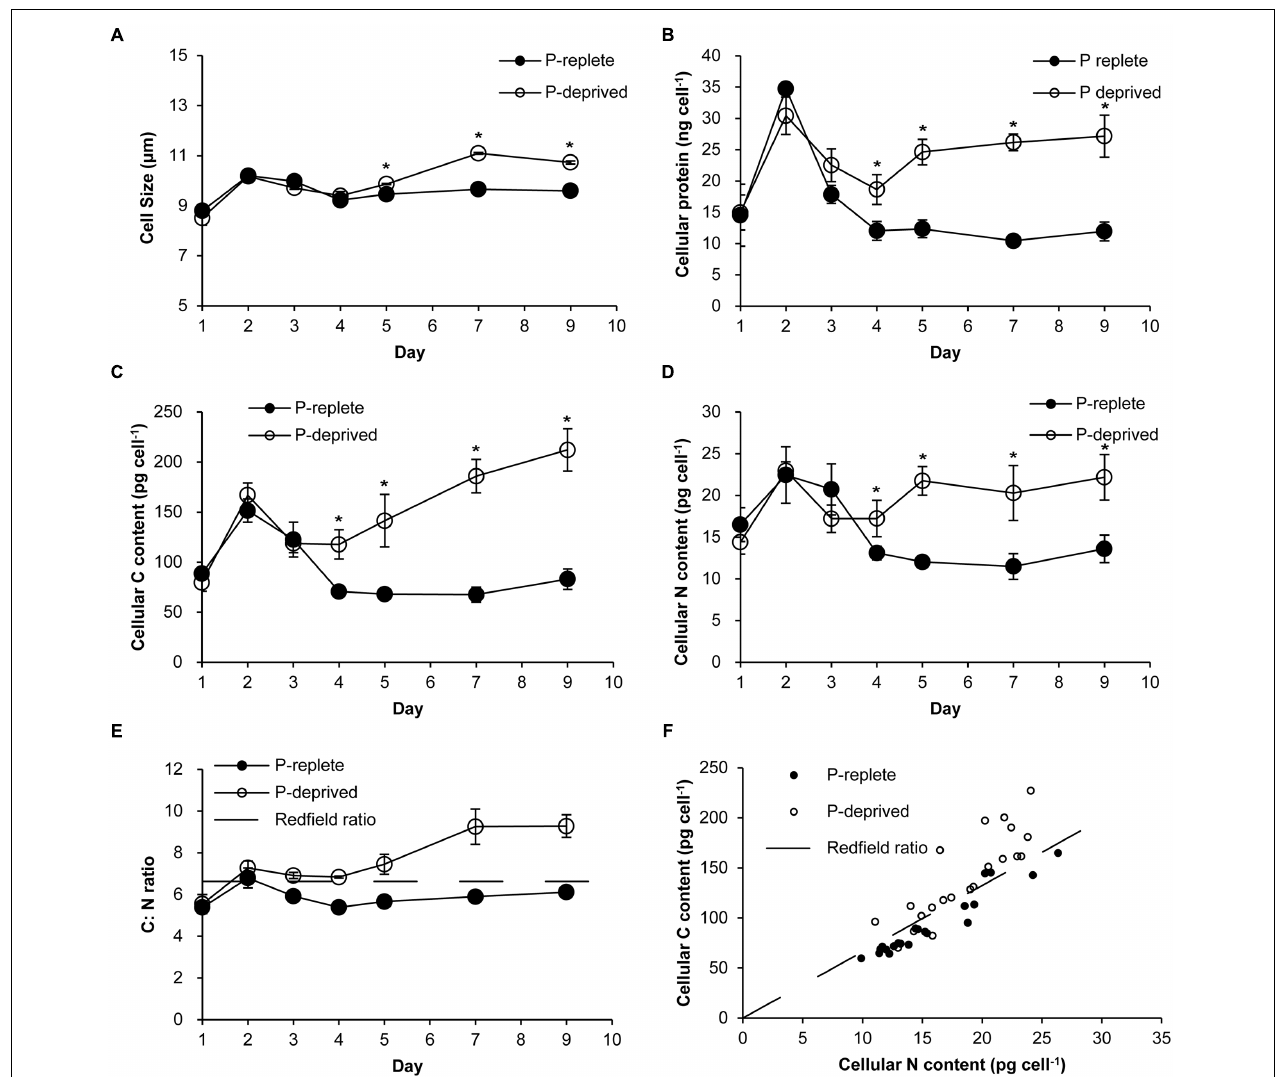
FIGURE 2 | Cellular parameters of A. carterae grown under the P-replete and P-deprived conditions. (A) cell sizes; (B) cellular protein content; (C) cellular carbon content; (D) cellular nitrogen content; (E) cellular C: N ratio; the dashed line depicts Redfield C: N ratio; (F) correlation between carbon and nitrogen contents; the dashed line depicts Redfield C: N ratio. Except in (F) , data shown are means ± standard deviations (error bars) from the triplicated cultures. Asterisks represent that significant differences between P-replete and P-deprived conditions were detected ( p <